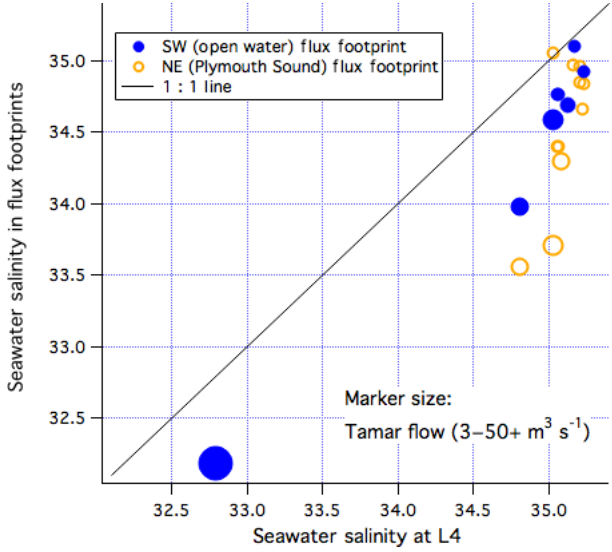
Figure 9. Salinity measured within the two air–water flux footprints of Penlee vs. near-coincidental measurements from the Quest at the L4 station. The size of the markers corresponds to the flow rate in the Tamar river, as measured at